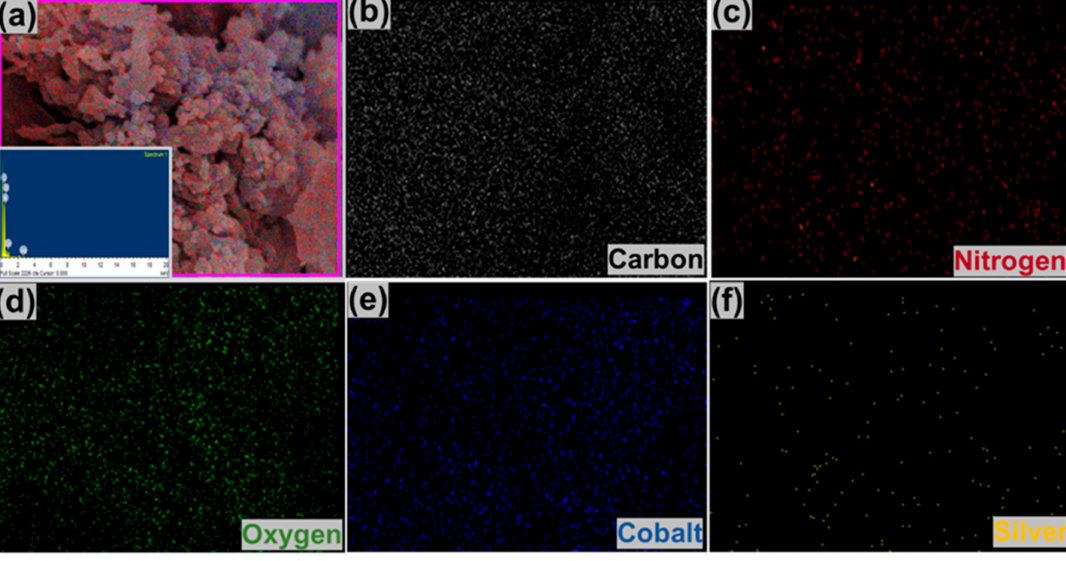
Figure 4. ( a ) EDS spectrum verifying the presence of the elements of the ternary nanocomposite (C, O, N, Co, and Ag) and showing scanned area image. EDS elemental mapping is presented by (b) C, ( c ) N, ( d ) O, ( e ) Co and ( f ) Ag contents of the Ag / Co 3 O 4 @PANI ternary